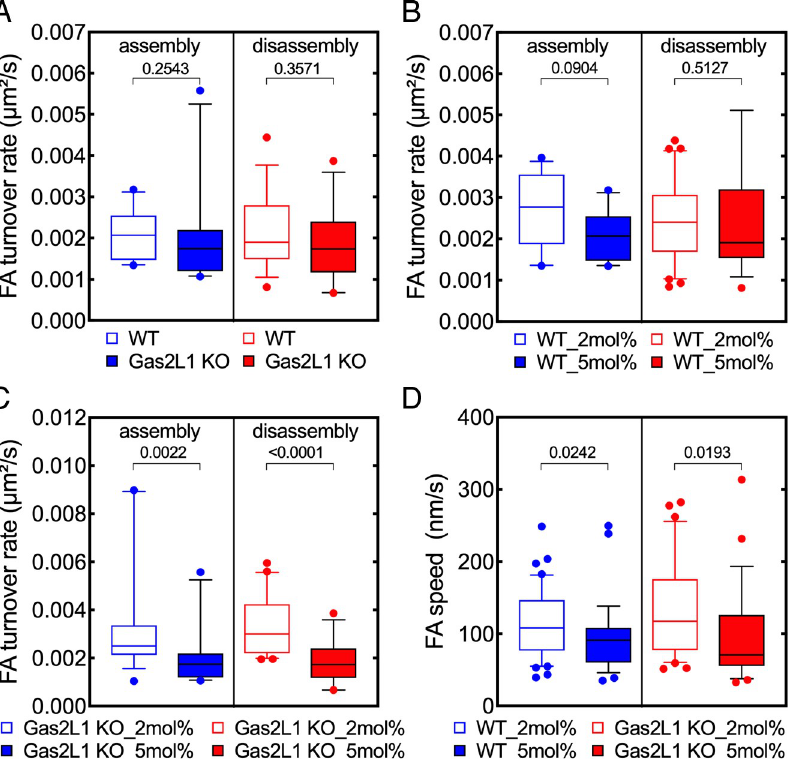
Fig 10. Increased microgel rigidity reduces focal adhesion turnover in wild-type and Gas2L1 KO Sertoli cells. (A-C) Control and Gas2L1 KO Sertoli cells seeded on to soft (2mol%) or rigid (5mol%) microgel arrays. Focal adhesions were imaged by TIRF microscopy and their assembly and disassembly rates were analyzed using a dedicated algorithm. Control and Gas2L1 KO cells show similar FA assembly and disassembly rates on 5mol% microgel arrays (A). Comparison of FA turnover in control cells on soft and rigid microgel arrays shows that FA assembly rate is slightly but significantly reduced in cells on rigid microgel arrays. FA disassembly rates were not significantly different (B). Notably, in Gas2L1 KO cells, both FA assembly and disassembly rates were reduced in cells on rigid microgel arrays (C). FA speed was also significantly lower in both control and Gas2L1 KO cells seeded on to rigid microgel arrays (D). Numbers indicate p